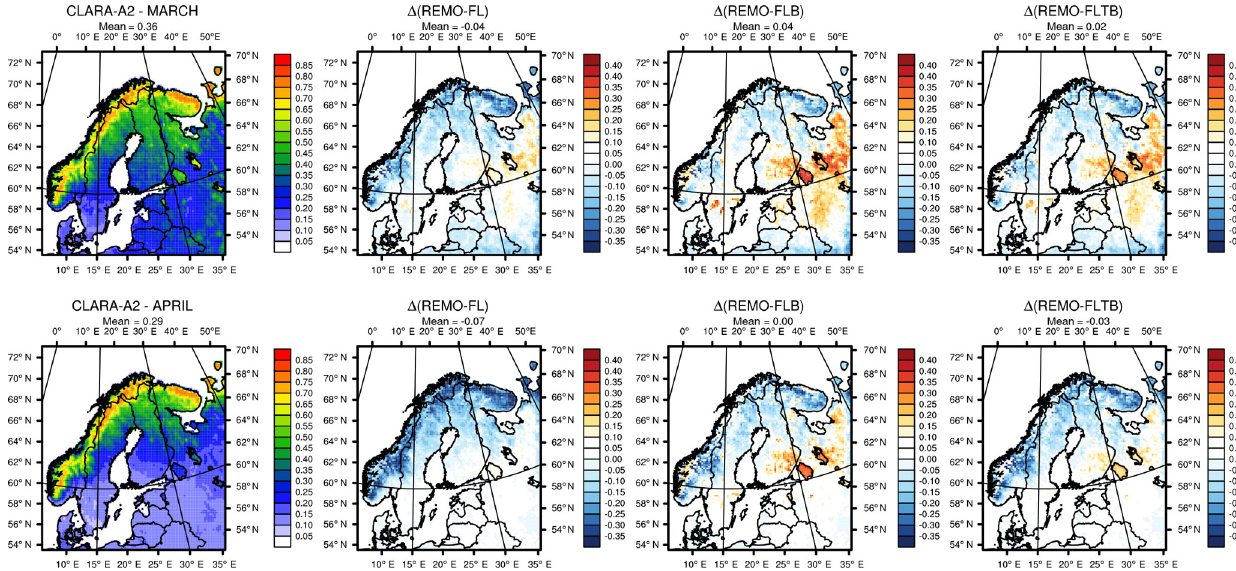
Figure 5. Monthly mean albedos for March and April from satellite data (CLARA-A2; Karlsson et al., 2017) and the corresponding bias (model–measurements) in the REMO-FL, REMO-FLB and REMO-FLTB runs. The monthly means are for the time period of 1982–2014 and only for land and lake